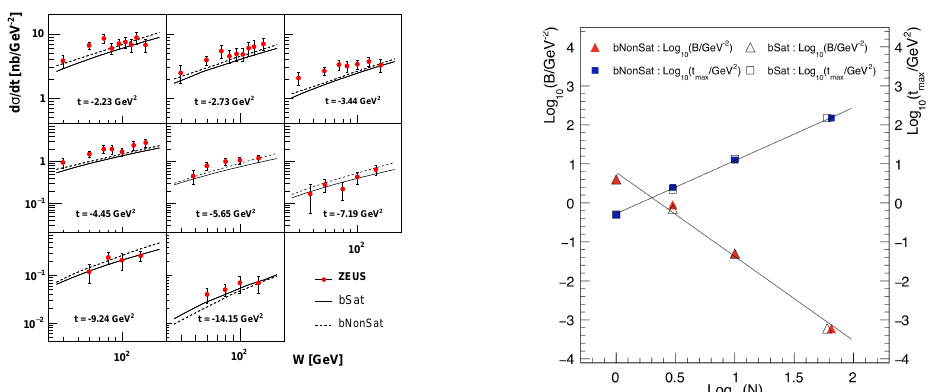
Figure 3: Left : Energy dependence of the incoherent J / Ψ production in the saturated and non-saturated version of the refined hotspot model, Right : Scaling behaviour of the spatial gluon density fluctuations inside the proton of the parameters B and